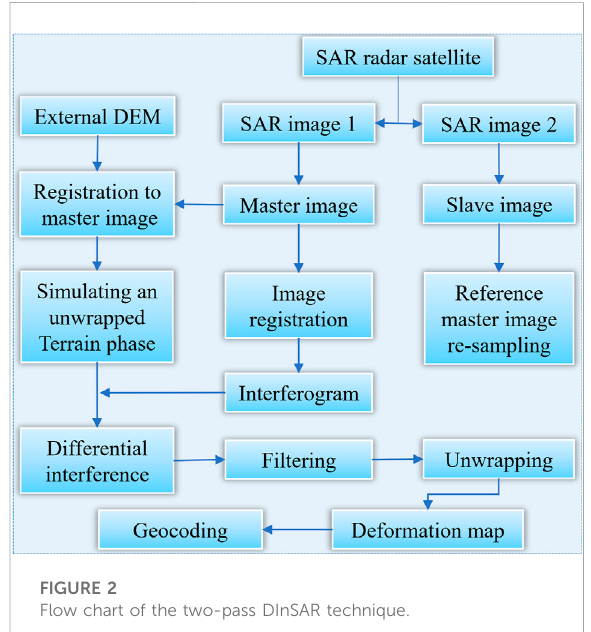
FIGURE 2 Flow chart of the two-pass DInSAR